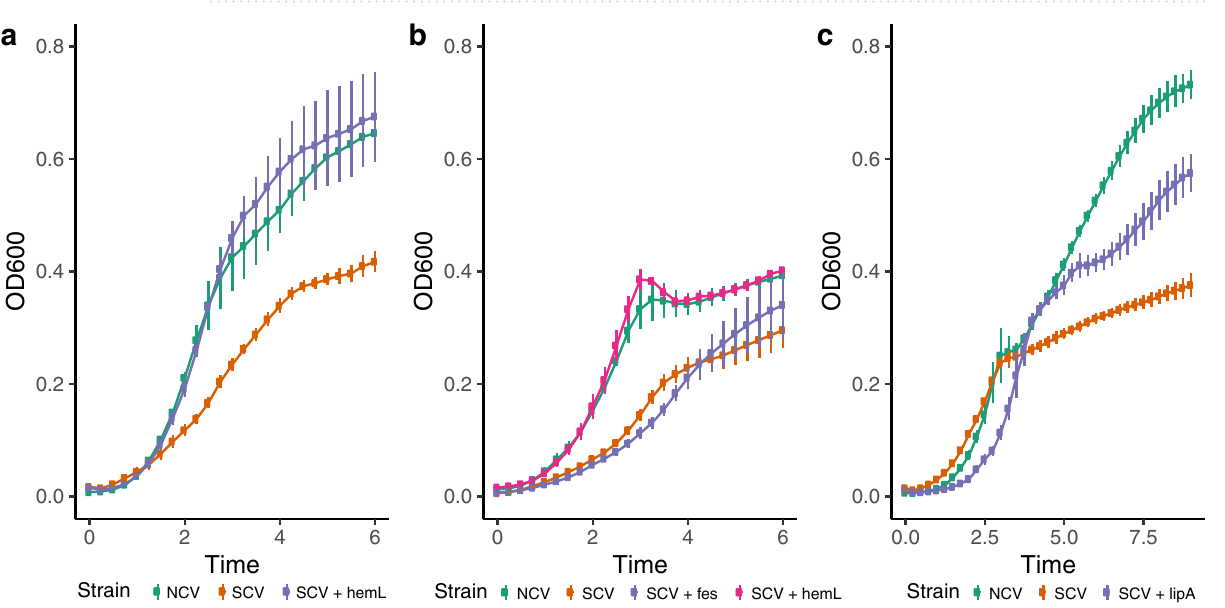
Figure 4. Lipoic acid biosynthesis as cause of small colony phenotype in Enterobacter hormaechei isolated from a bloodstream infection in a patient with end-stage renal disease. Genomic sequencing of the paired NCV and SCV isolates revealed multiple genomic lesions including single nucleotide substitutions in entD , hemN , and pqqB along with large-scale rearrangements leading to disruption of the lipA gene. ( a ) Genetic rescue with lipA restored normal growth from the Enterobacter hormaechei SCV. ( b ) Chemical rescue with lipoic acid restored normal growth in Enterobacter hormaechei SCV. ( c ) Cross-feeding from Enterobacter hormaechei NCV restores growth of SCV, consistent with a diffusible factor required for growth. All plates in this figure were incubated under aerobic conditions.